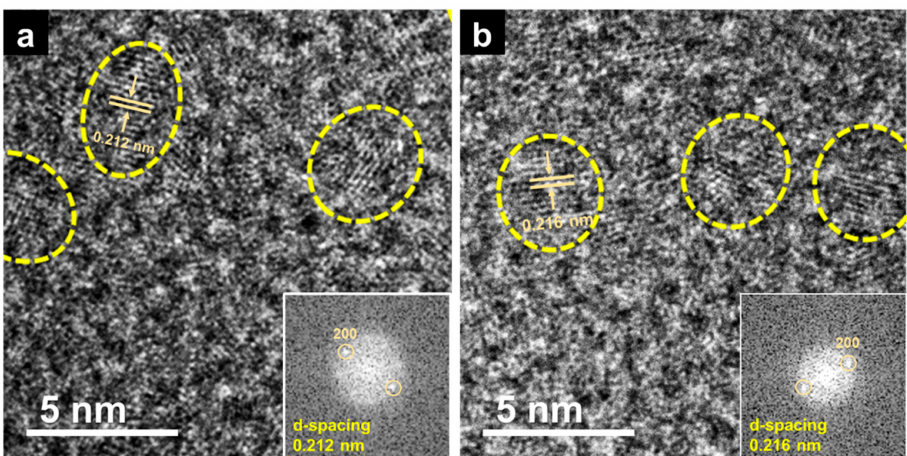
Figure 2. HRTEM images and FFT information (inset of the lower right in the image) with the d-spacing value of NPs at the substrate bias of 0 V under ( a ) 20 mTorr and ( b ) 80 mTorr.